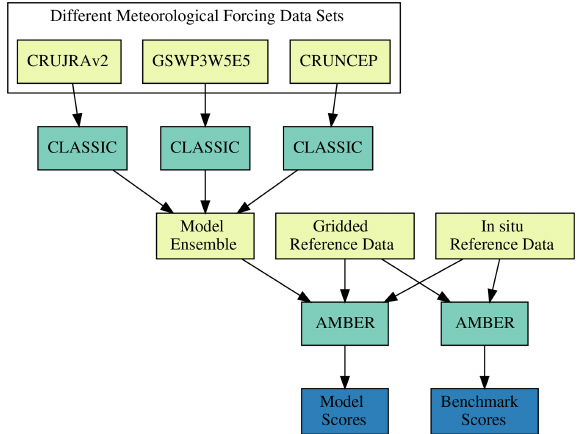
Figure 3. Experimental setup, where yellow boxes refer to data, green boxes to algorithms, and blue boxes to analysis